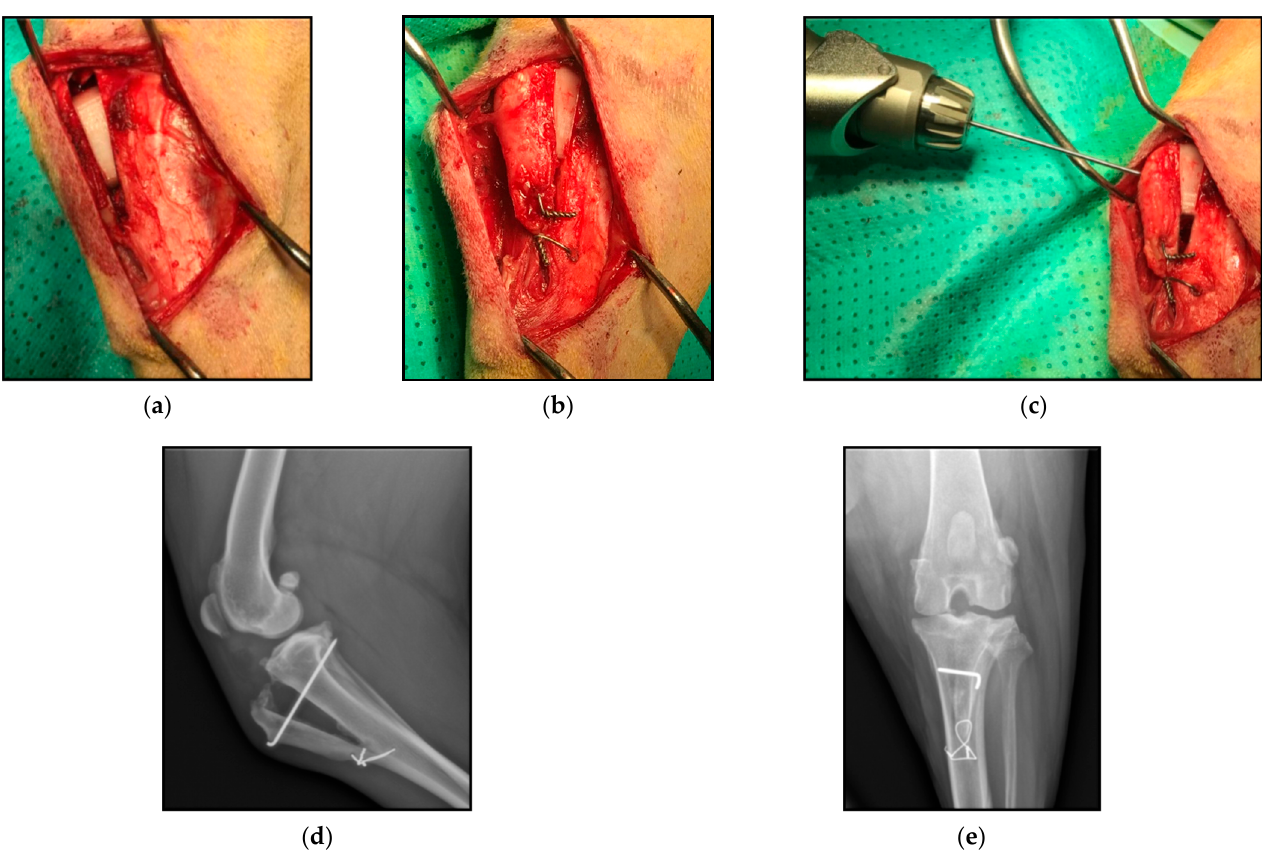
Figure 4. Surgical technique. ( a ) Implant placement. ( b ) Tension band wiring. ( c ) Pin placement. ( d , e ) Final result of the technique.